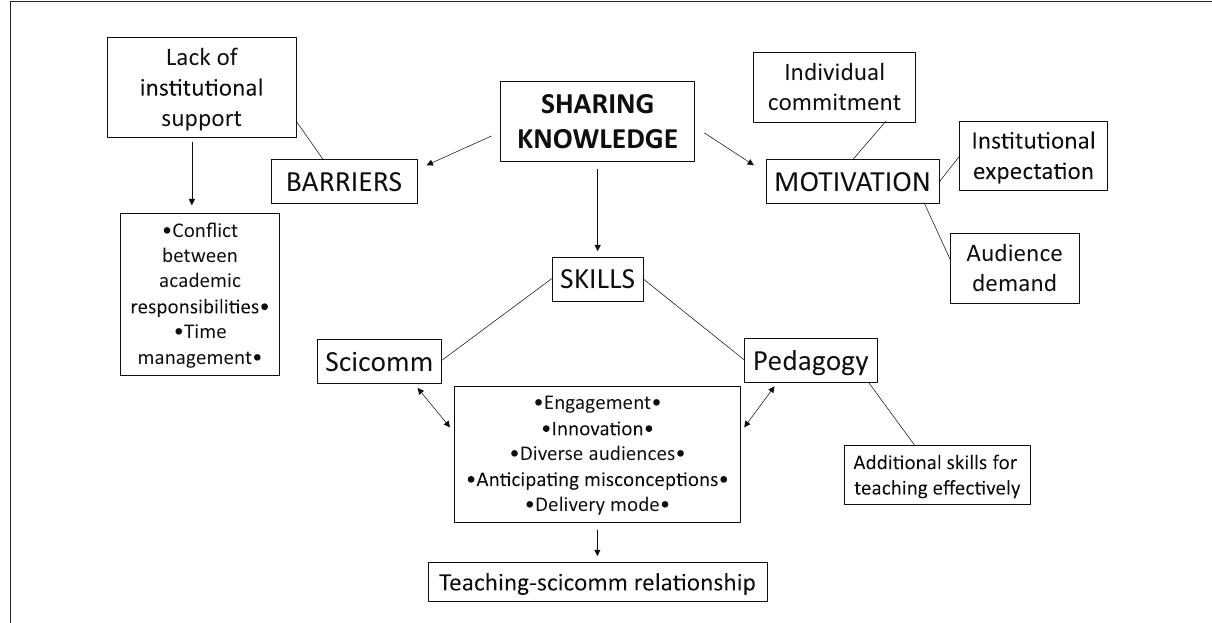
FIGURE2 Final thematic map of sharing knowledge in the palaeosciences, incorporating the main themes and subthemes emerging from the one-on-one interview and focus group.